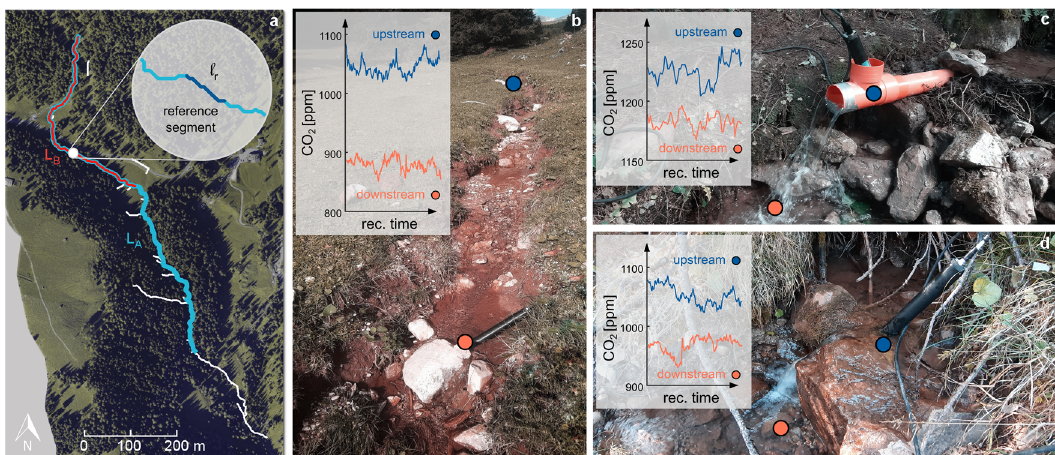
Fig.1|FocusreachoftheValfreddacreekandexperimentalsetup.a planarview of the reach selected for this study, shown with an orthophoto of the eastern part of the Valfredda catchment in background. Here, light blue and red indicate reach A , with length L A =1060m, and reach B , with length L B =543m, respectively. The inset within the planar view shows the reference segment without steps of length ℓ r =13m. b overview of the reference segment indicated in ( a ). c Example of an